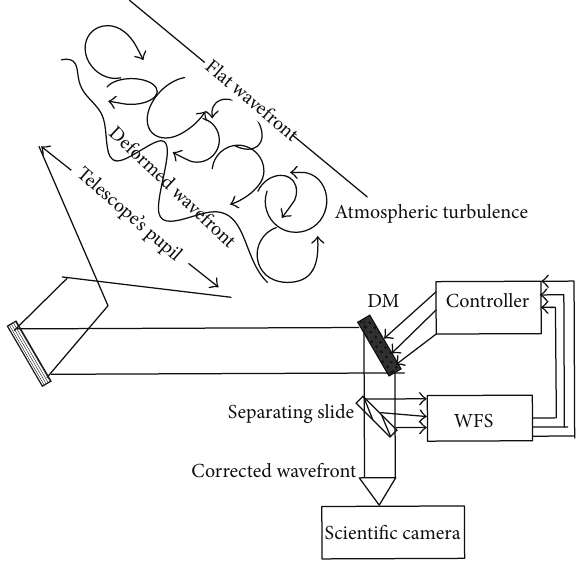
Figure 1: Works of adaptive optical system for imaging compensa-